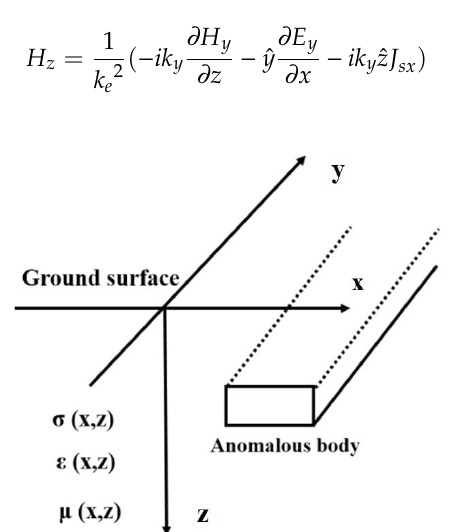
Figure 2. Two-dimensional geo-electric mode diagram.